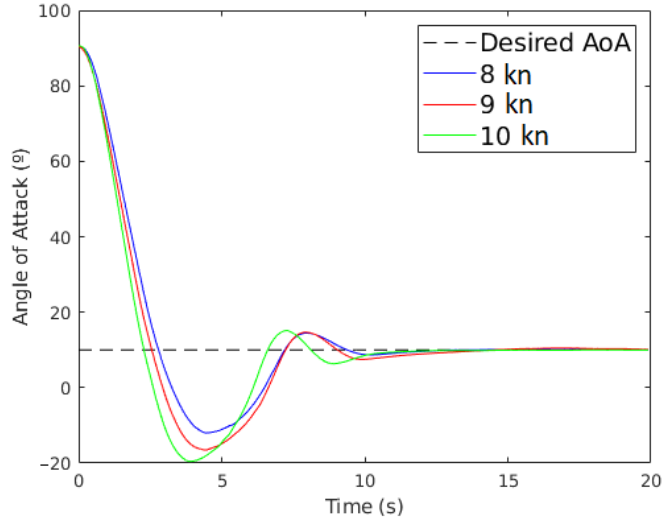
Figure 12. Time response of the wing sail AoA ( K p = 0.05, K d = 0.07, α i = 90°, α f = 10°).